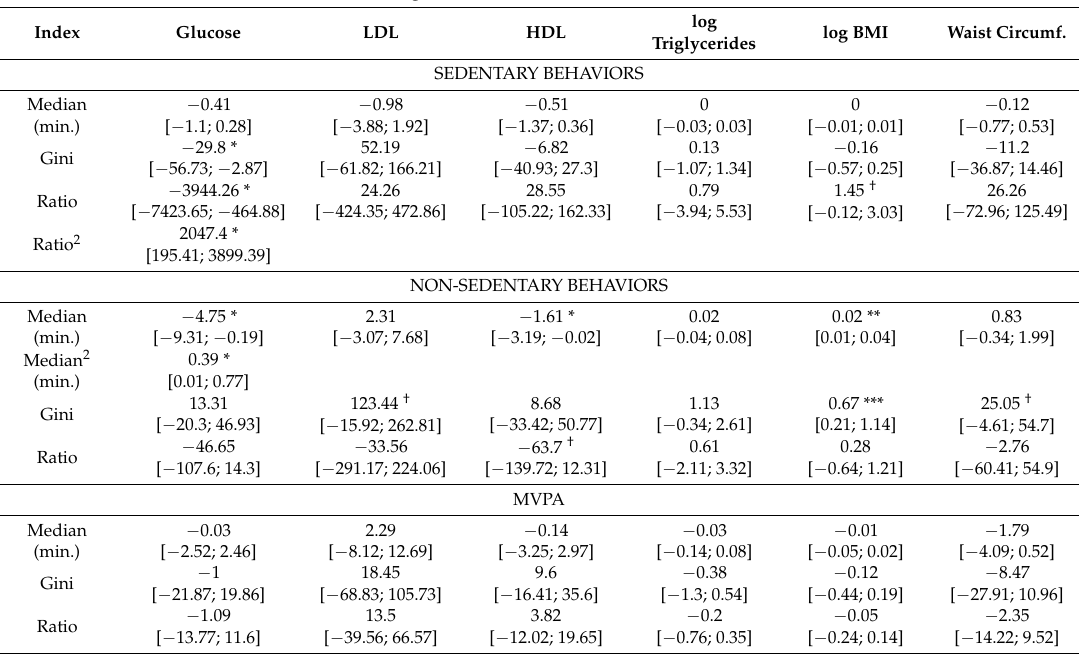
Table 5. Coefficients and 95% confidence intervals of linear regression models of various partitioning indices against health variables. The top section refers to sedentary bouts (lying or sitting). The middle section refers to non-sedentary behaviors (standing, Light Physical Activity (LPA) or Moderate to Vigorous Physical Activity (MVPA)). The bottom section refers to MVPA. Quadratic terms are reported when they significantly improve the model. Levels of p -values: † <0.1; * <0.05; ** <0.01; *** <0.001. Results of Partitioning Models (Coefficients and 95% Confidence